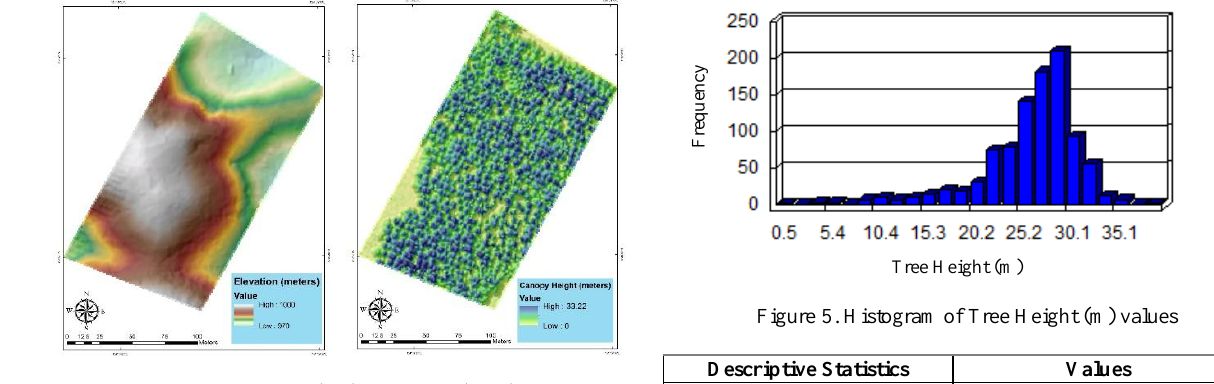
Figure 2. DTM (left) and CHM (right)